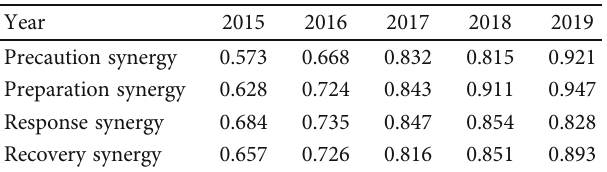
Table 6: Order degree of the CME management synergy process subsystem in Henan Province.